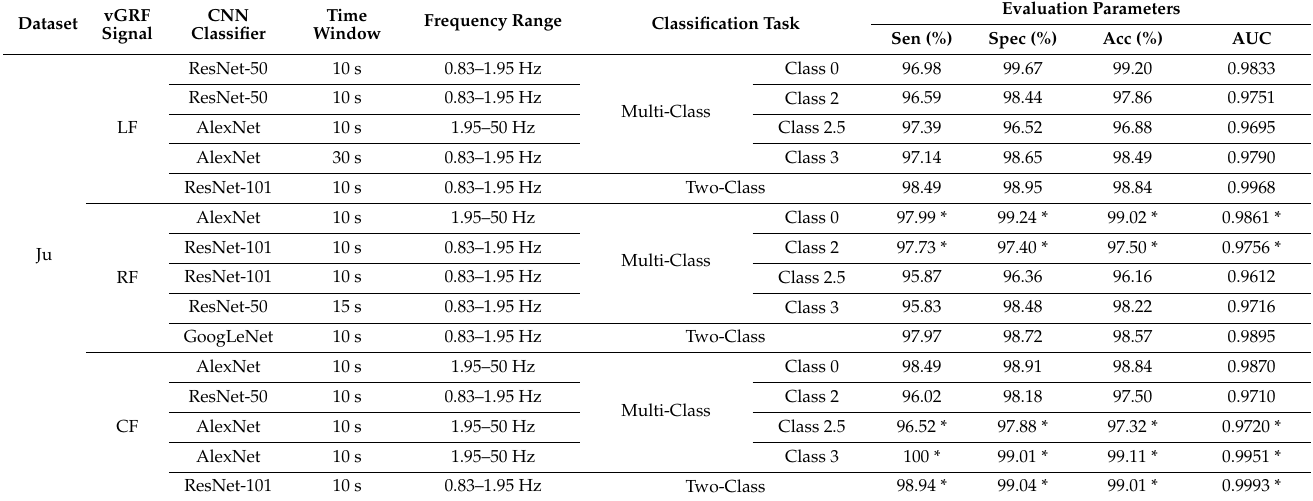
Table 21. Multi-class (CO (Class 0) vs. PD Stage 2 (Class 2) vs. PD Stage 2.5 (Class 2.5), and PD Stage 3 (Class 3)) and two-class classification (CO vs. PD (Class 2, Class 2.5, and Class 3)) summary using several CNN classifiers (AlexNet, ResNet-50, ResNet-101, and GoogLeNet) with 10-fold cross-validation for Ju